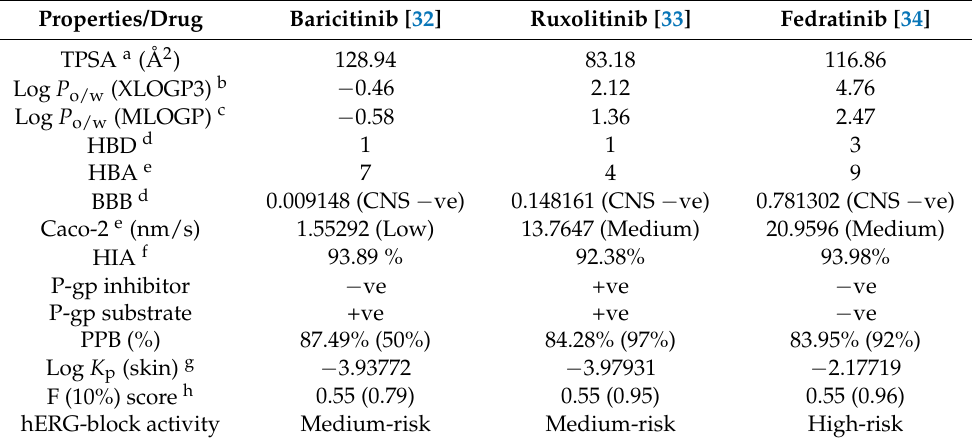
Table 1. Calculated physicochemical parameters (TPSA, XLOGP3, and MLOGP) of Baricitinib, Ruxolitinib, and Fedratinib.